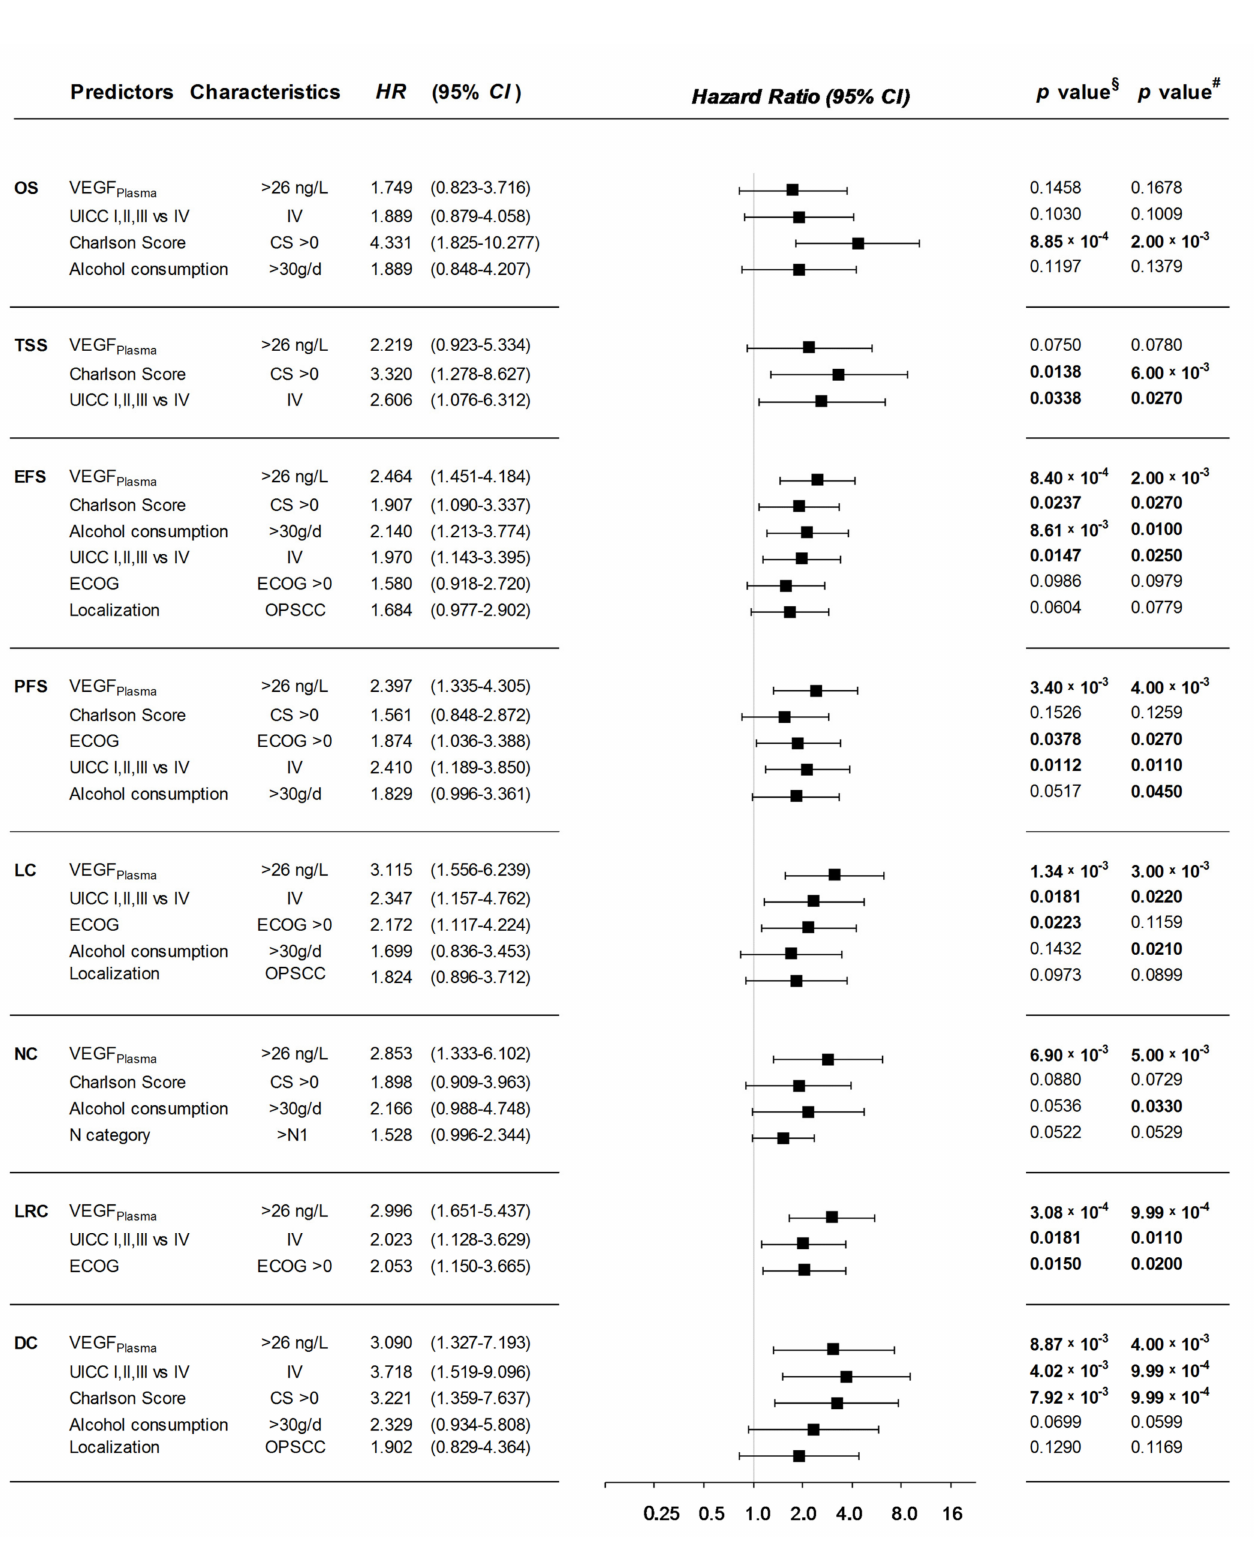
Figure 5. Forrest plots for independent predictors for (OS) overall survival, (TSS) tumor-specific survival, (EFS) event-free survival, (PFS) progression-free survival, (LC) local control, (NC) nodal control, (LRC) loco-regional control, and (DC) distant control from multivariate Cox proportional hazard models build step wise using the likelihood-ratio forward method reaching the highest significance in combined cohorts of HNSCC patients. § p values from multivariate Cox proportional hazard model; # p values from multivariate Cox proportional hazard model applying bootstrapping using 1000